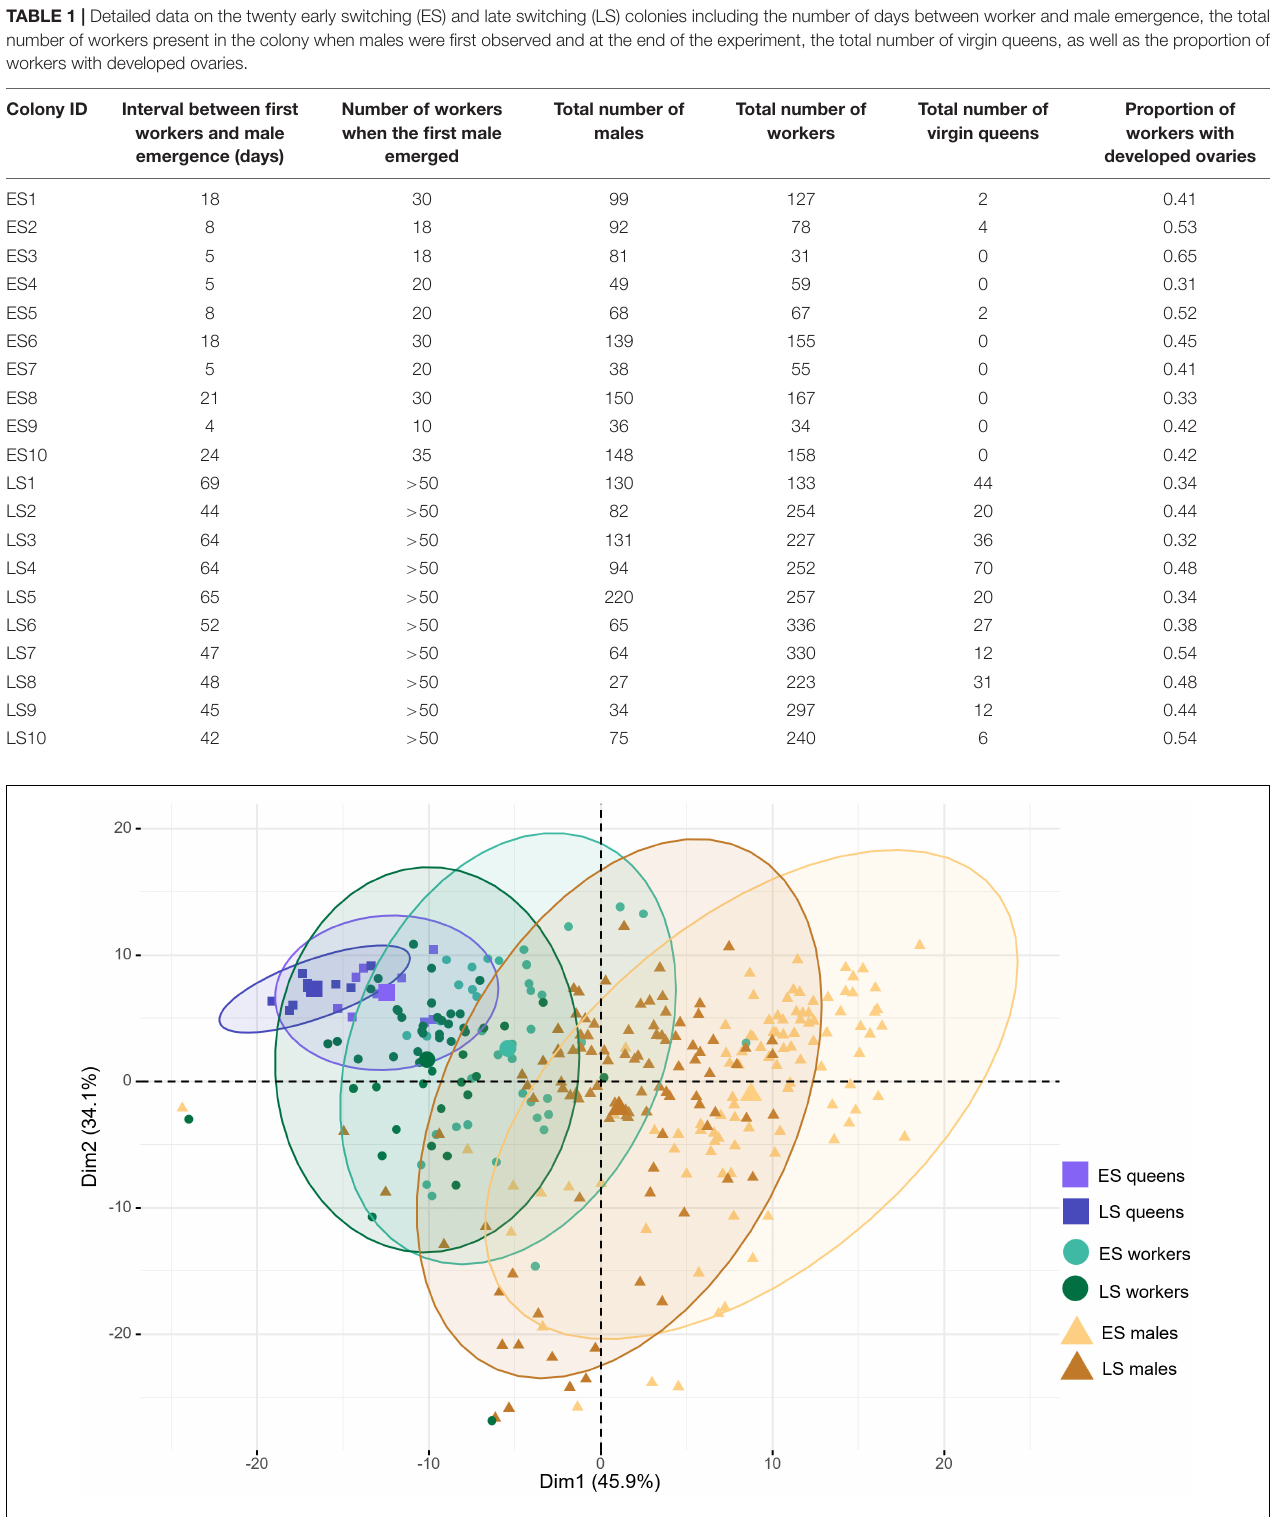
FIGURE 2 | Principal component analysis of CHCs extracted from queens, males and workers of early (ES) and late switching (LS) colonies. Sex and caste membership are represented by the different symbols (queens = squares, workers = circles and males = triangles) with the centroid of the overall profile groups shown as the large symbol in the center of each 95% confidence interval ellipse. Different shades of each color show the two colony phenotypes for each caste or sex.